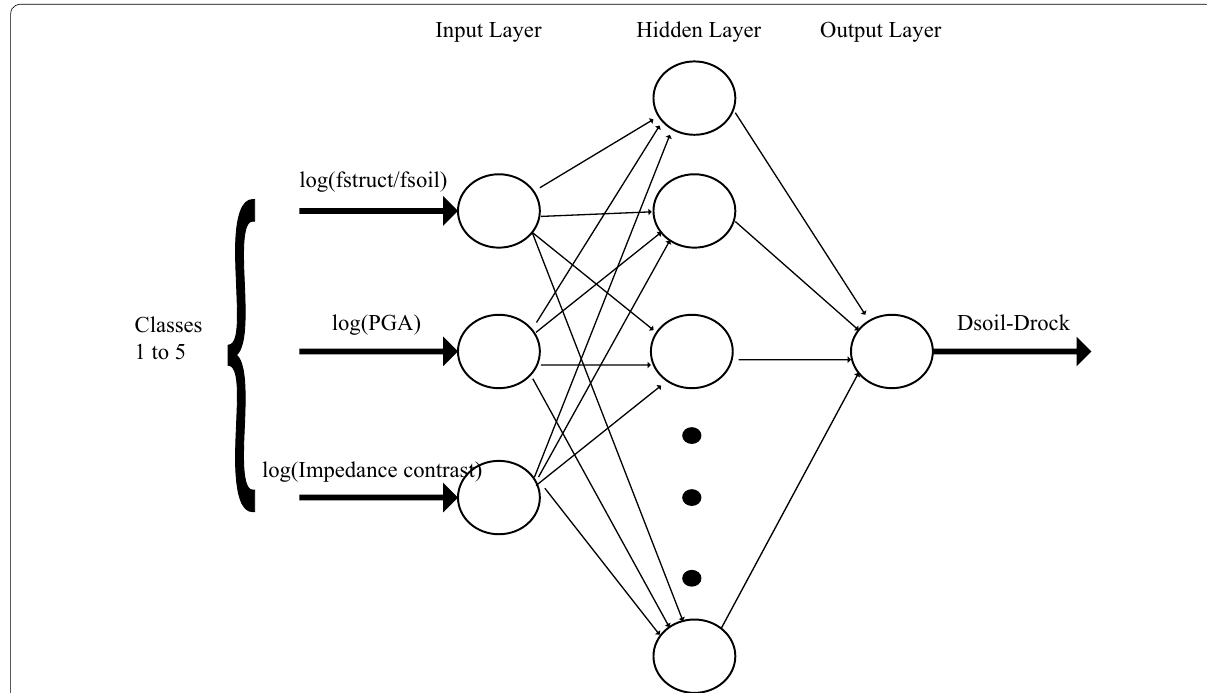
Fig. 3 Architecture of the neural network selected for each of the five typology classes: Inputs are the structure‑to‑soil frequency ratio, the velocity contrast and the PGA; the output is the damage increment index between rock and